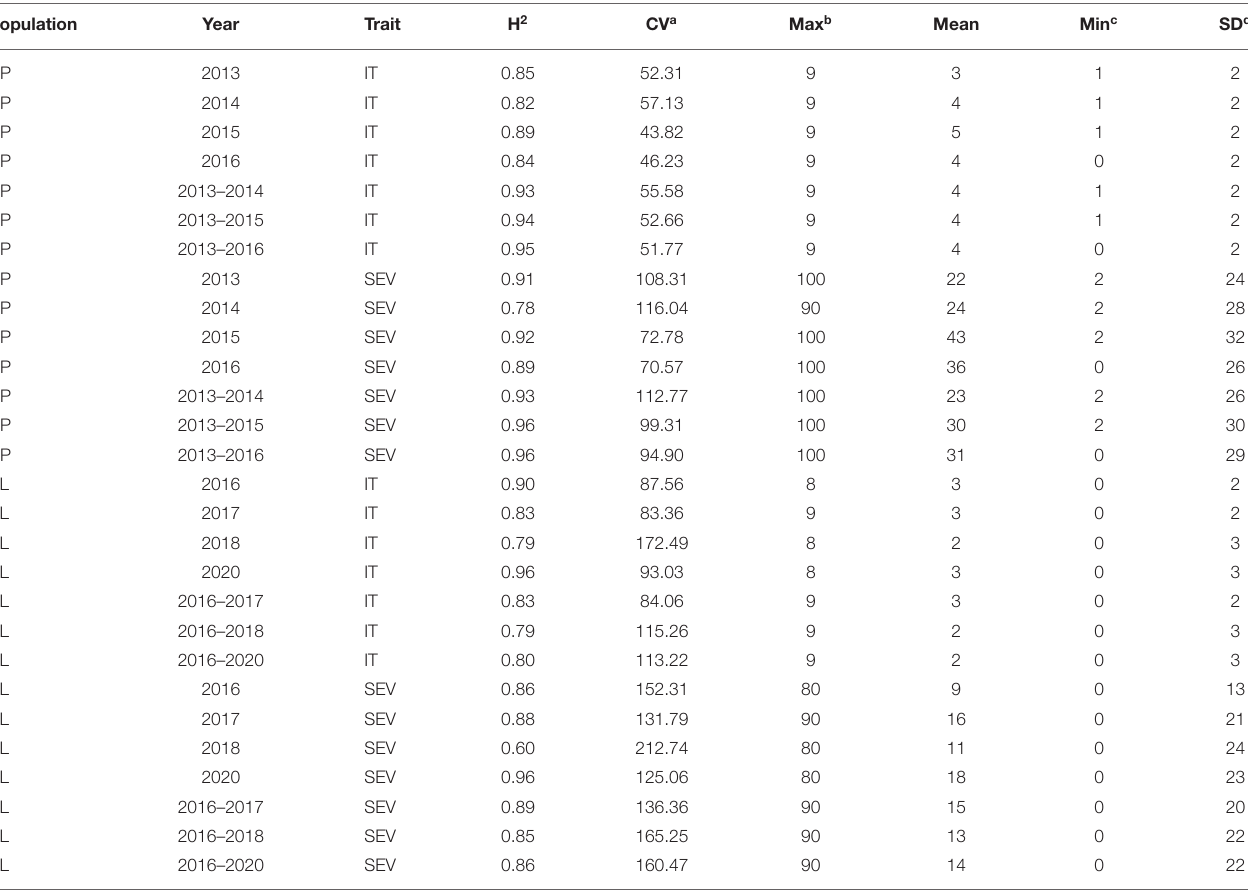
TABLE 2 | Stripe rust IT and disease SEV heritability (H 2 ) and trial statistics for unadjusted phenotypes in the DP and BL training population phenotypes from 2013 to 2016 and 2016 to 2020. Population